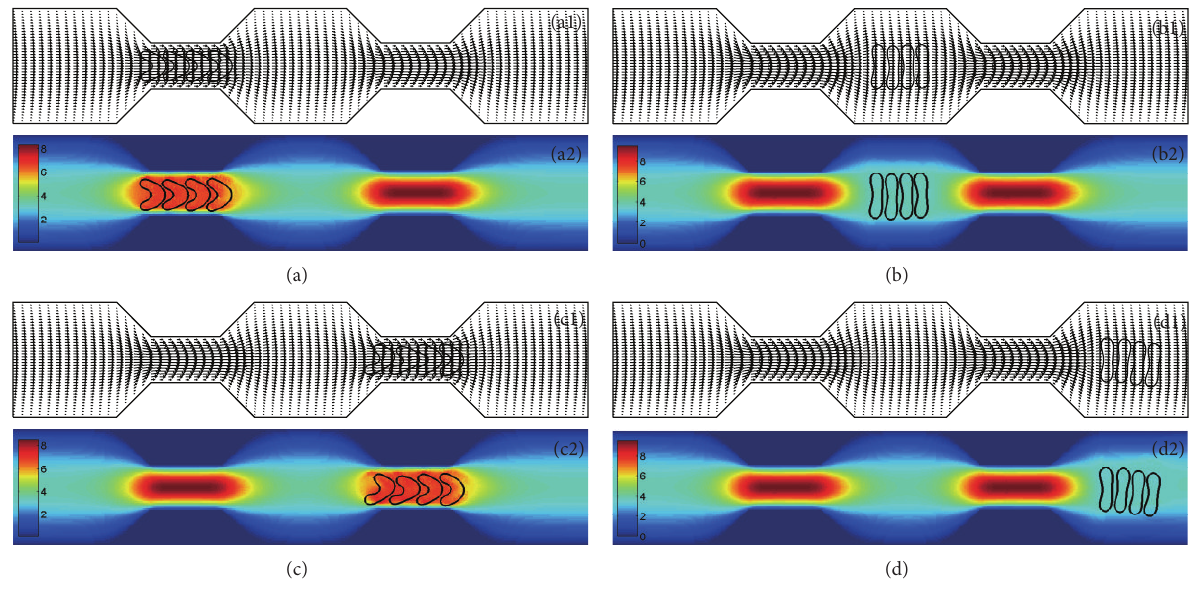
Figure 8: Motion and dissociation of a four-cell erythrocyte aggregate in a 8 𝜇 m stenotic channel at time instants (a) 𝑡 = 0.48 ms; (b) 𝑡 = 0.91 ms; (c) 𝑡 = 1.30 ms; and (d) 𝑡 = 1.72 ms. Velocity vectors (a1-d1) and axial velocity magnitude contours (cm/s) (a2-d2) are presented. The initial configuration for the aggregate is shown in Figure 1(c), and the aggregate is vertically placed in the channel initially. The parameters used are 𝐷 𝑒 = 1.0 × 10 −2 𝜇 J/m 2 , 𝑘 𝑏 = 5.0 × 10 −13